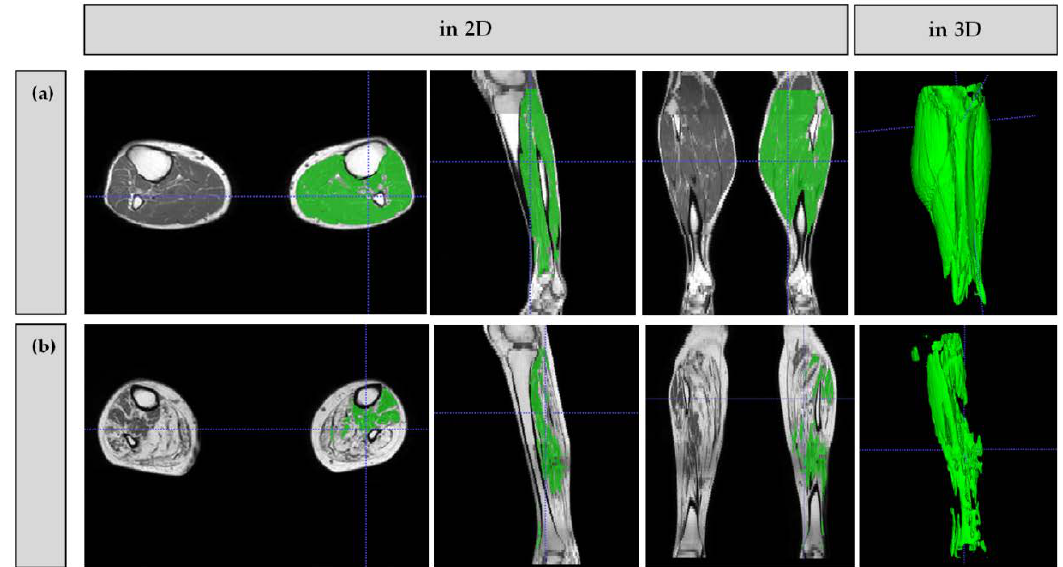
Figure 3. Exemplary segmentation results (left lower leg) of a mildy affected CIDP patient (( a ) muscle volume 2030.2 cm 3 ) and a severely affected CMT patient (( b ) muscle volume 478.4 cm 3 ).